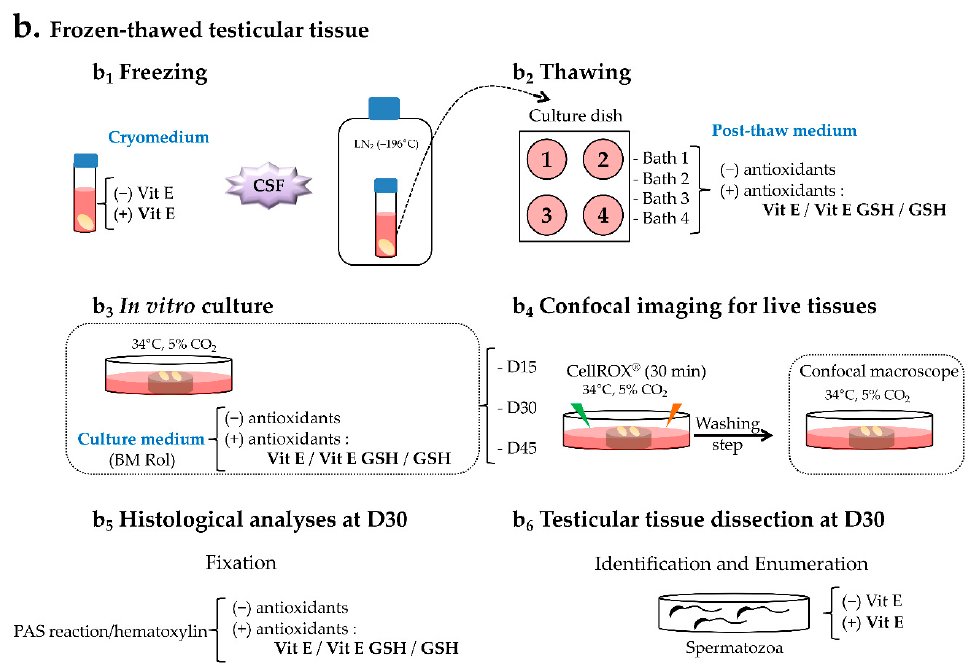
Figure7. In vitrocultureprocedureandpost-cultureanalysisusingfreshandfrozen-thawedprepubertal mouse testes with or without antioxidant supplementation. ( a ) Schematic overview of in vitro culture procedure of fresh and F-T prepubertal mouse testicular tissue ( a 1 ) combined with live confocal imaging for tissue cultured until D15, D30, D45, and D60 of culture ( a 2 ). ( b ) Scheme showing the freezing, thawing, and in vitro culture procedures of prepubertal mouse testis combined with the set of experiments performed with or without antioxidant supplementation. Prepubertal mouse testes were frozen in a cryopreservation medium supplemented or not supplemented with Vit E, using a controlled slowfreezingprotocolbeforestorageintoliquidnitrogen( b 1 ). Post-thawmediumconsistedoffourbaths containing or not containing Vit E, Vit E combined with GSH, or GSH ( b 2 ). F-T prepubertal testicular fragments were cultured with a medium supplemented or not supplemented with antioxidant(s) ( b 3 ). Confocal live imaging of the cultured tissue was performed at D15, D30, and D45 ( b 4 ). Cytoplasmic and nuclear ROS formation during in vitro culture of testicular fragments was detected using the CellROX kit after incubation during 30 min at 34 ◦ C, 5% CO 2 ( a 2 ,b 4 ). At D30 of culture, histological analysis was performed to quantify the yield of in vitro spermatogenesis using periodic acid Schi ff (PAS) reaction counterstained with hematoxylin ( b 5 ). Spermatozoa were identified and counted using Shorr coloration after mechanical dissection of the cultured F-T testicular fragments at D30 in culture medium supplemented or not supplemented with Vit E ( b 6 ). (*), Media tested with fresh explant; (#), media tested with F-T explant; (–), absence; ( + ), presence; BM, basal medium; CSF, controlled slow freezing;